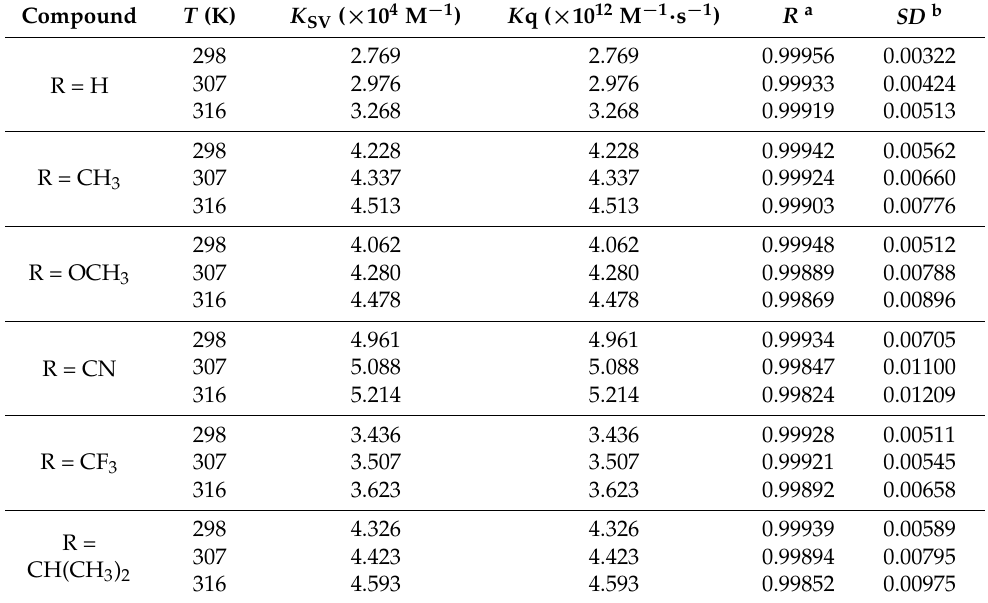
Table 1. Stern-Volmer quenching constants for the interactions of PDQL with HSA at different temperatures.